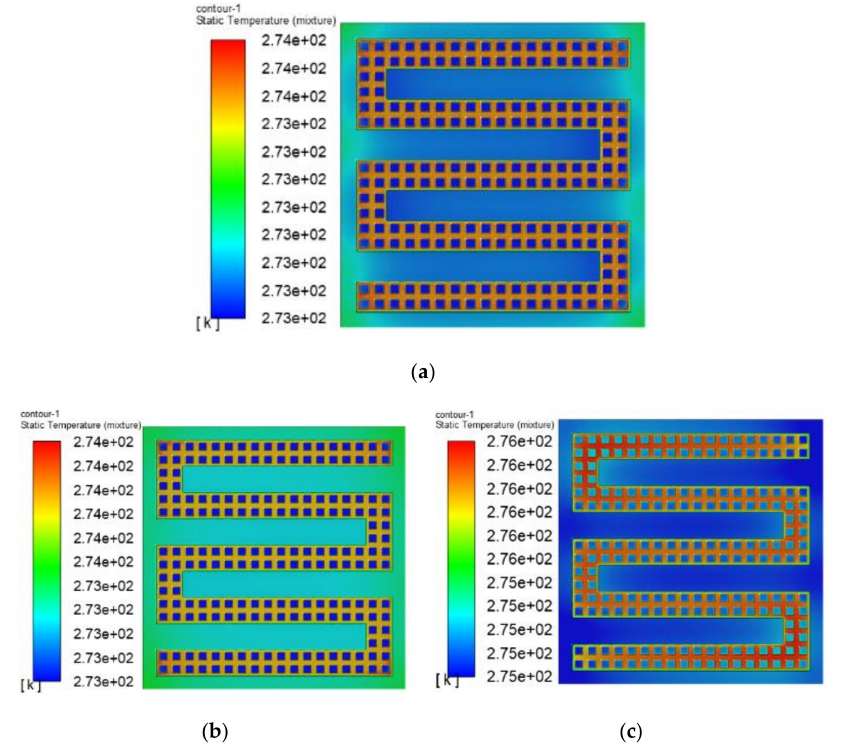
Figure 26. The fuel cell temperature contours with pore diameter = 1.2 mm at di ff erent times; ( a ) t = 32 s, ( b ) t = 42 s, ( c ) t = 48